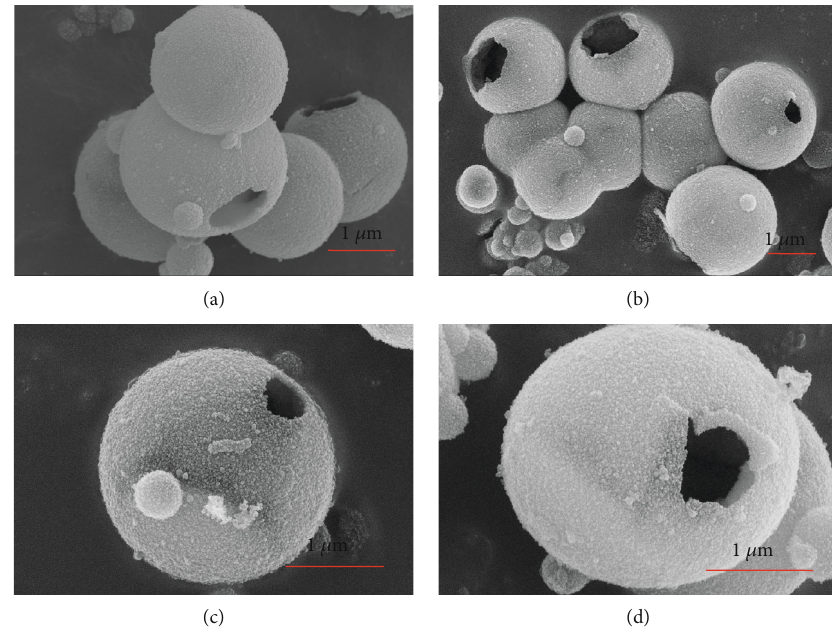
Figure 2: FESEM images of (a)TiO